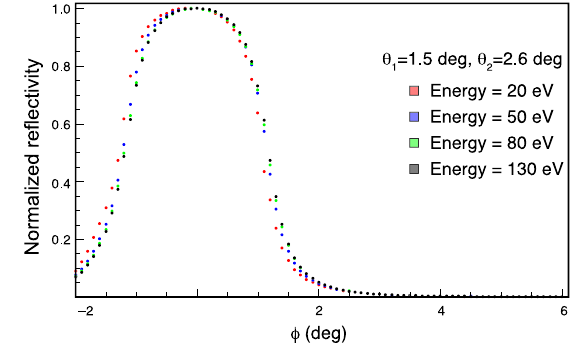
FIG. 21. Data sets Th5-Th6: scan of θ 2 for two energies, with fixed θ 1 ¼ 3 °, aluminum sample #1.